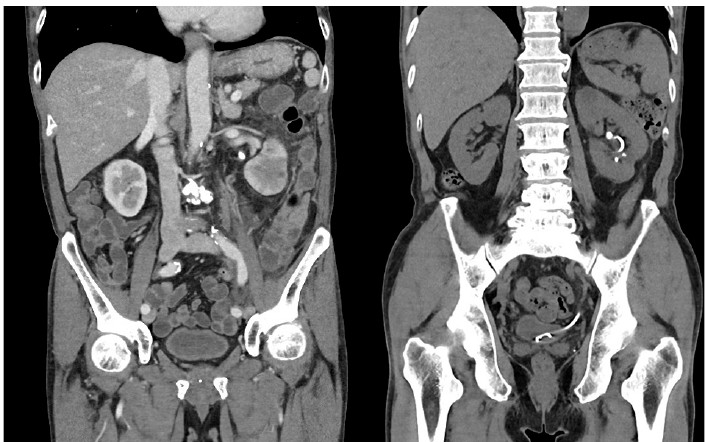
Figure 2. Initial and preoperative CT images of a patient presenting with a proximal ureteral stone with infection. In the right image, the stone migrated to the upper calyx with the inserted ureteral stent. This patient had an mS-ReSC score of 5 (one stone in the renal pelvis and two stones in the inferior minor calyces ).